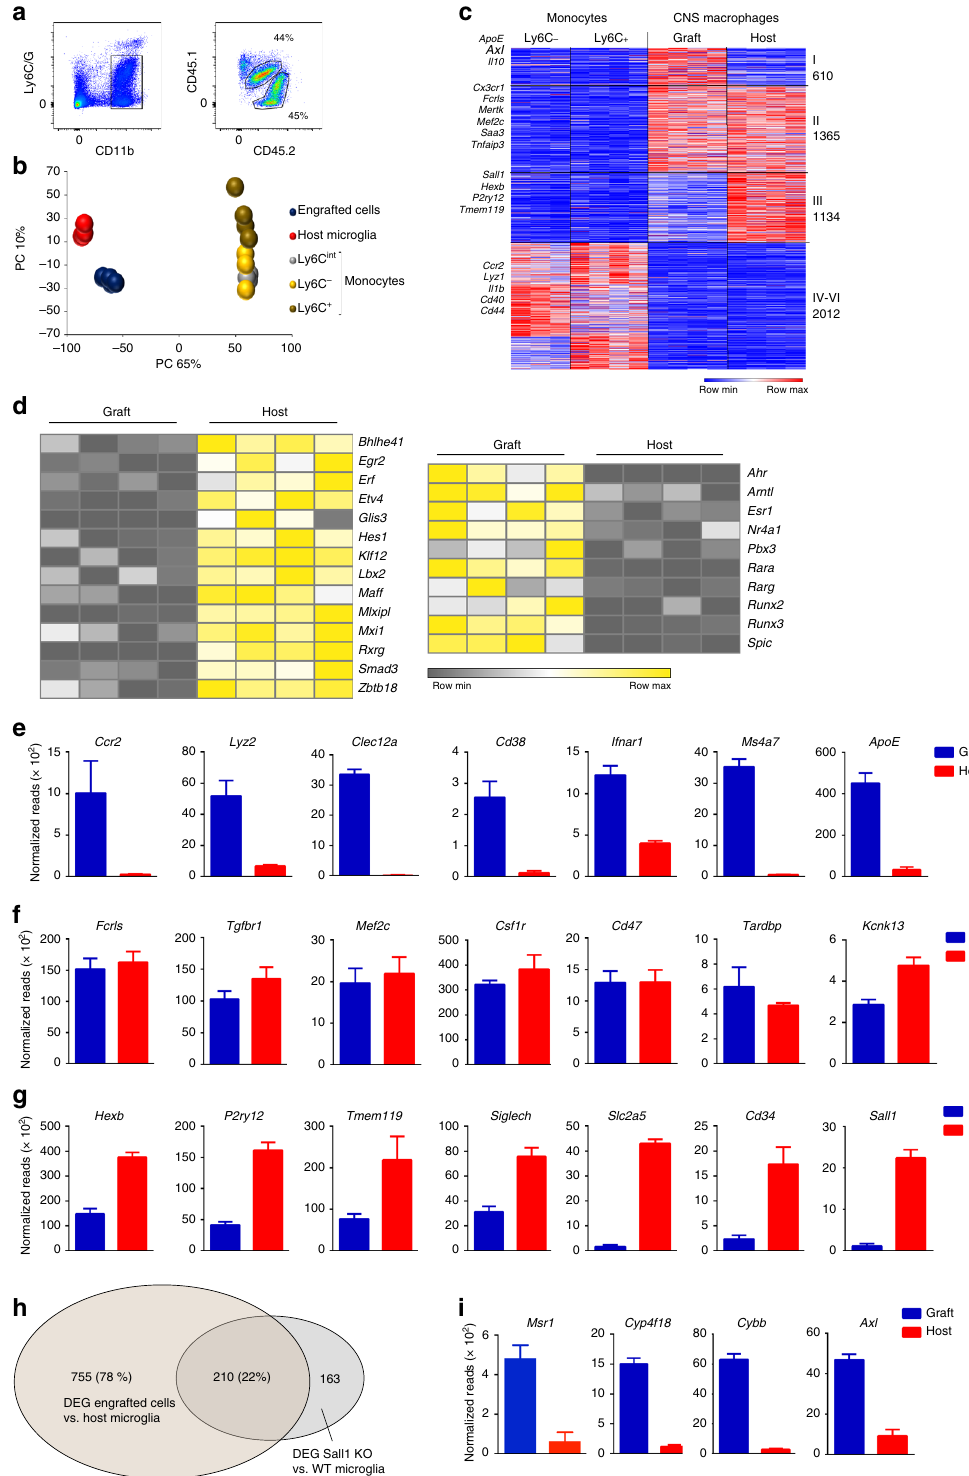
DEG Sall1 KO vs.